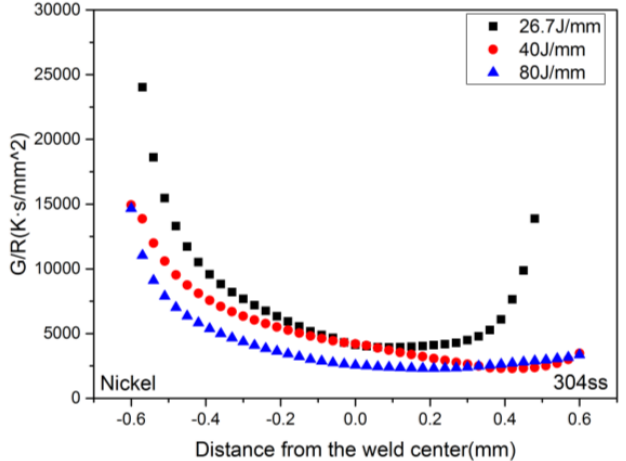
Figure 10. Spatial distribution of the G/R under different heat input.